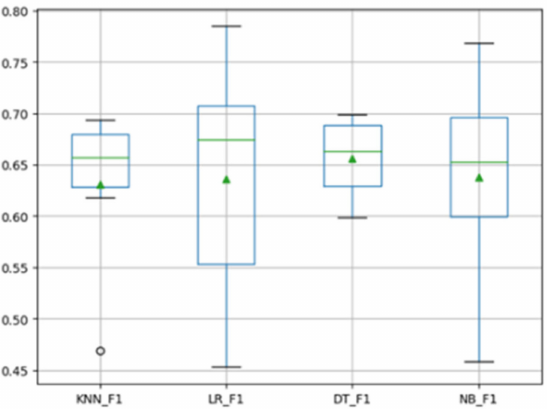
Figure 5. F1 values obtained by different classifiers on the AEEEM